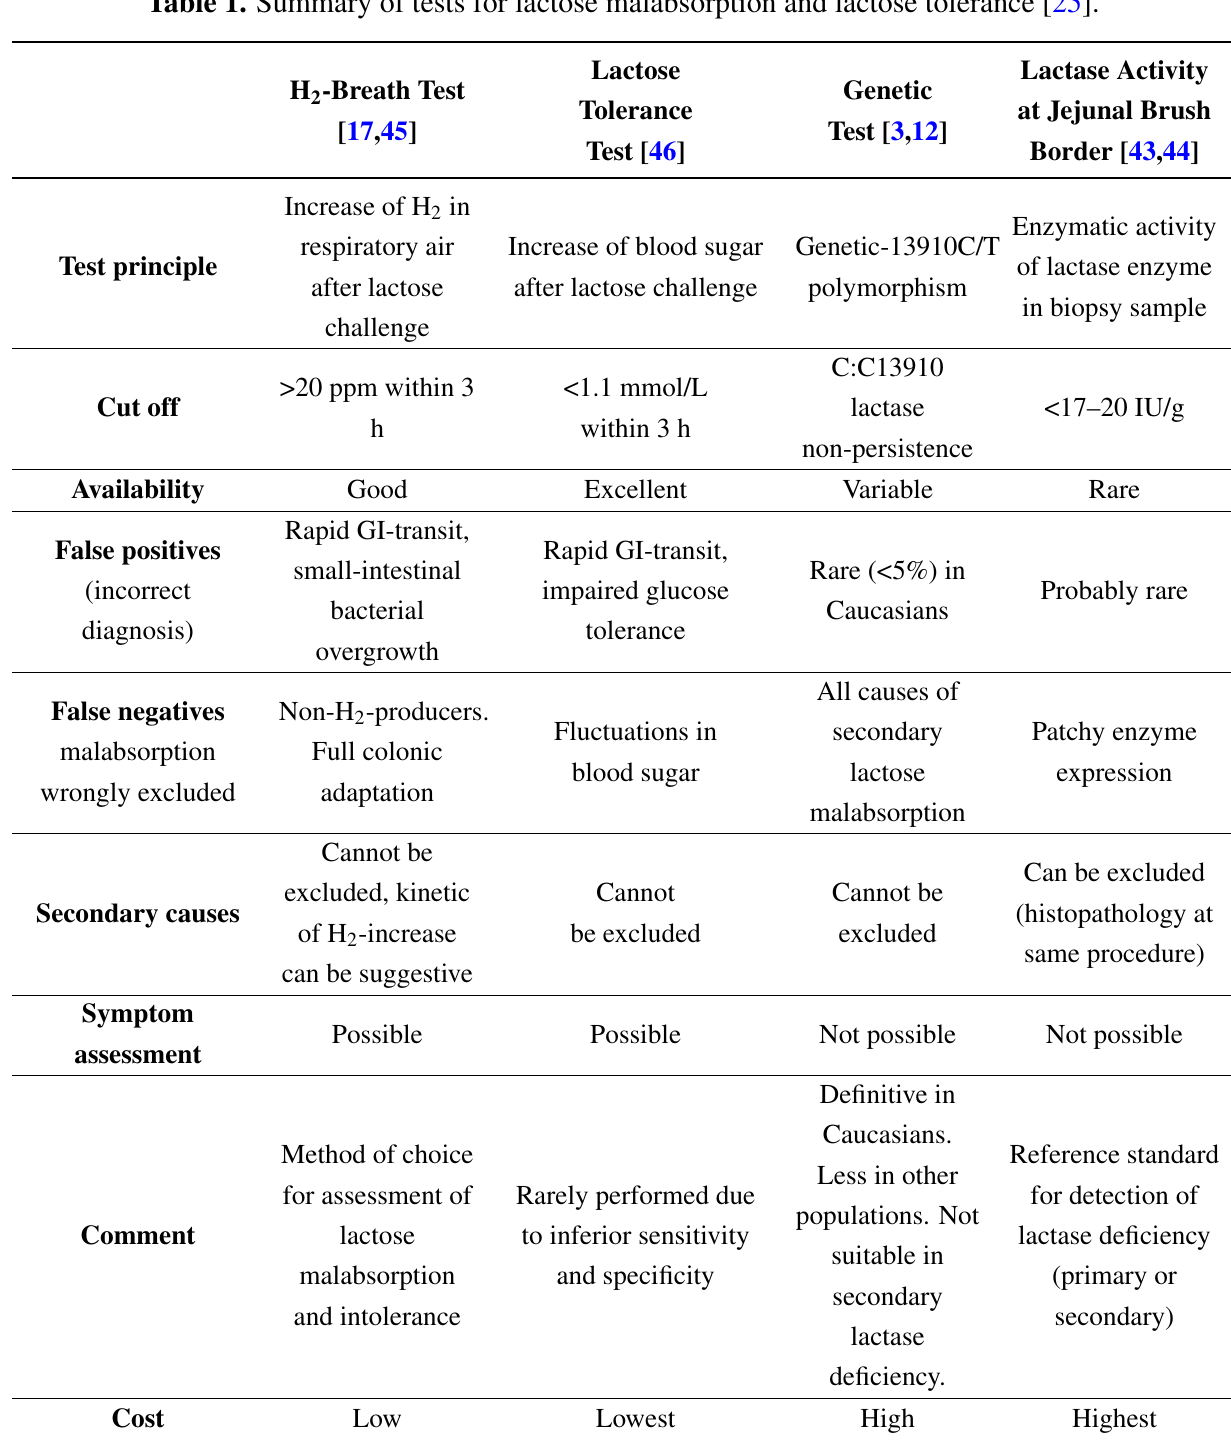
Table 1. Summary of tests for lactose malabsorption and lactose tolerance